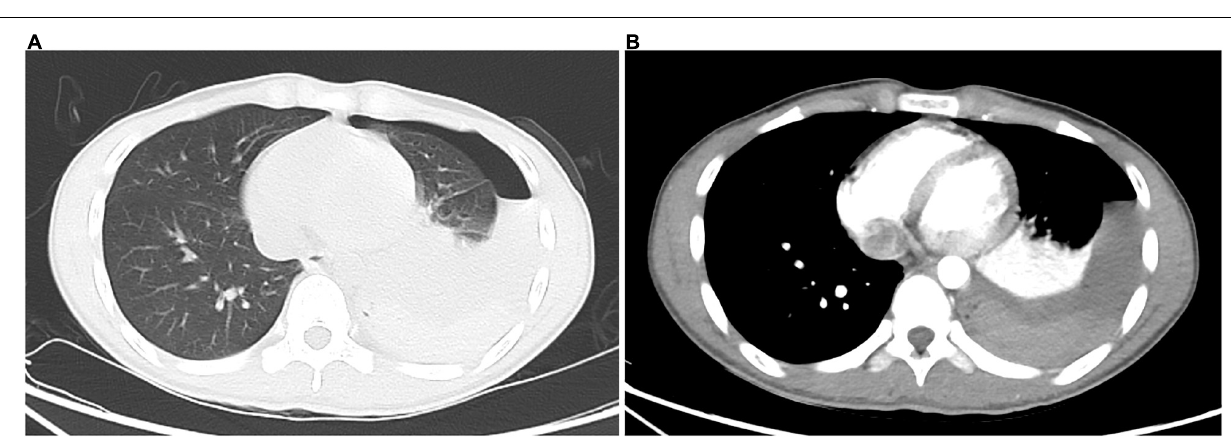
FIGURE 2 | Contrast-enhanced chest computed tomography. (A) The lung window shows left hydropneumothorax; dorsal side of left lower lobe shows consolidation, which presents as atelectasis after compression. (B) The mediastinal window shows left hydropneumothorax; consolidation of the dorsal side of the left lower lobe is enhanced, which presents as atelectasis after compression; high-density lesion in the left dorsal pleural cavity has no enhancement, which is a blood clot; no blood vessels with abnormal morphology and density or contrast agent leaking into the thoracic cavity are